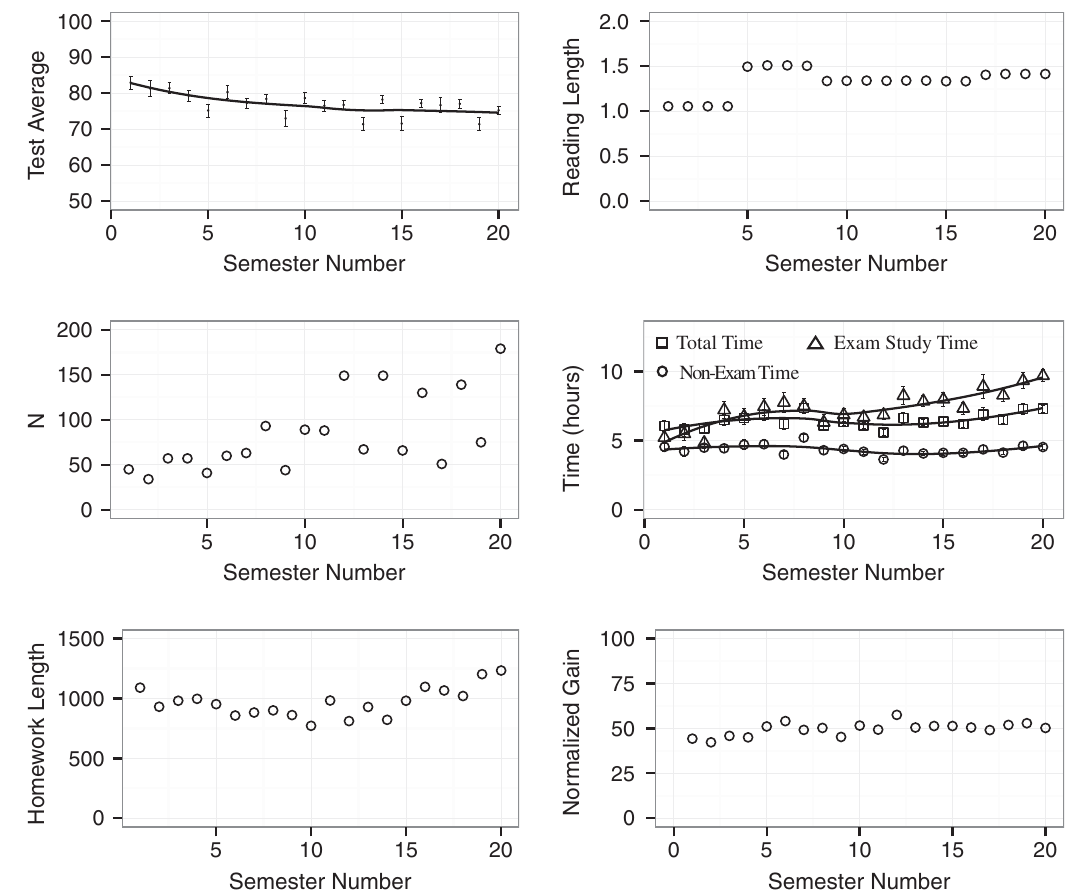
FIG. 1. Variation in class parameters. The average on the first two tests, the number of students included in the study ( N ), the total length of the homework measured by the number of independent steps in the solutions, the length of the reading measured in the number of characters in millions of characters in the LaTex file used to generate the course textbook, the normalized gain on the CSEM, and the overall averages of the time variables. All quantities are plotted against the semester number. Semesters are numbered beginning in Fall